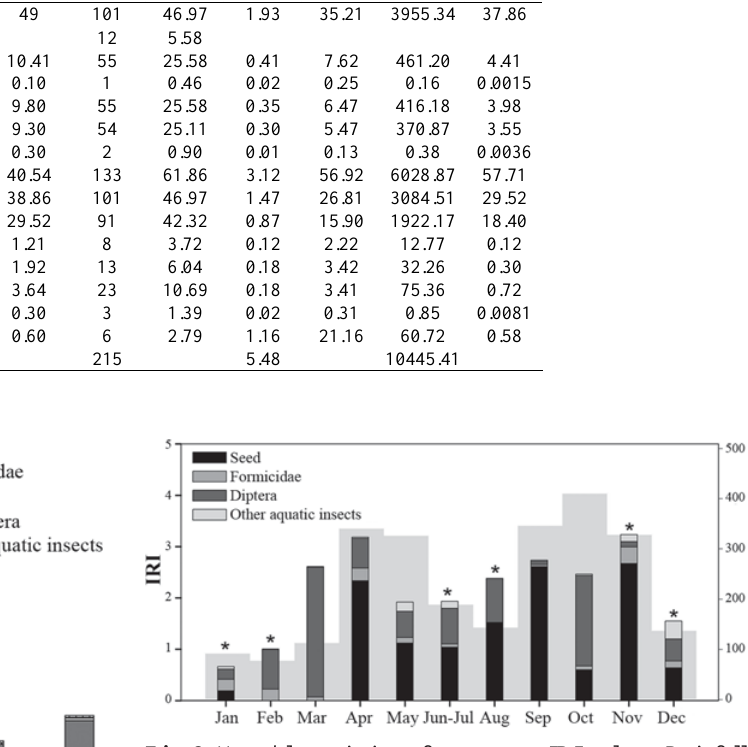
Fig. 2. Monthly variation of prey types-IRI values. Rainfall follows a bimodal seasonal pattern (shadow on background). The asterisks show the months in which reproduction occurs.